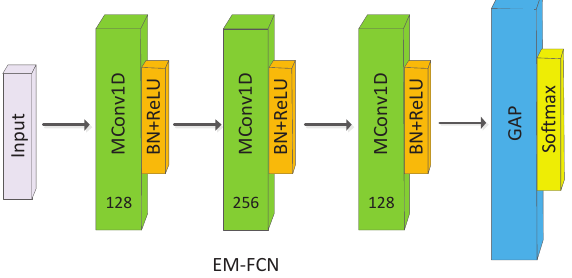
Figure 3. Architecture of EM-FCN, MConv1D denotes the one-dimensional MConv layer. Compared with the EM-FCN, the EM-ResNet is deeper. It has three bottlenecks, which consist of three basic modules like EM-FCN. The number of kernels corresponding to three bottlenecks is 64, 128, and 128, respectively. Convolutional layers are only replaced by MConv layers in the residual branches for stable training.